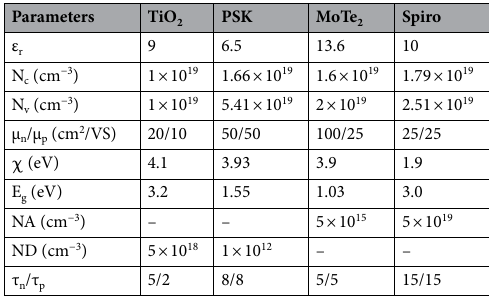
Table 1. The input simulation